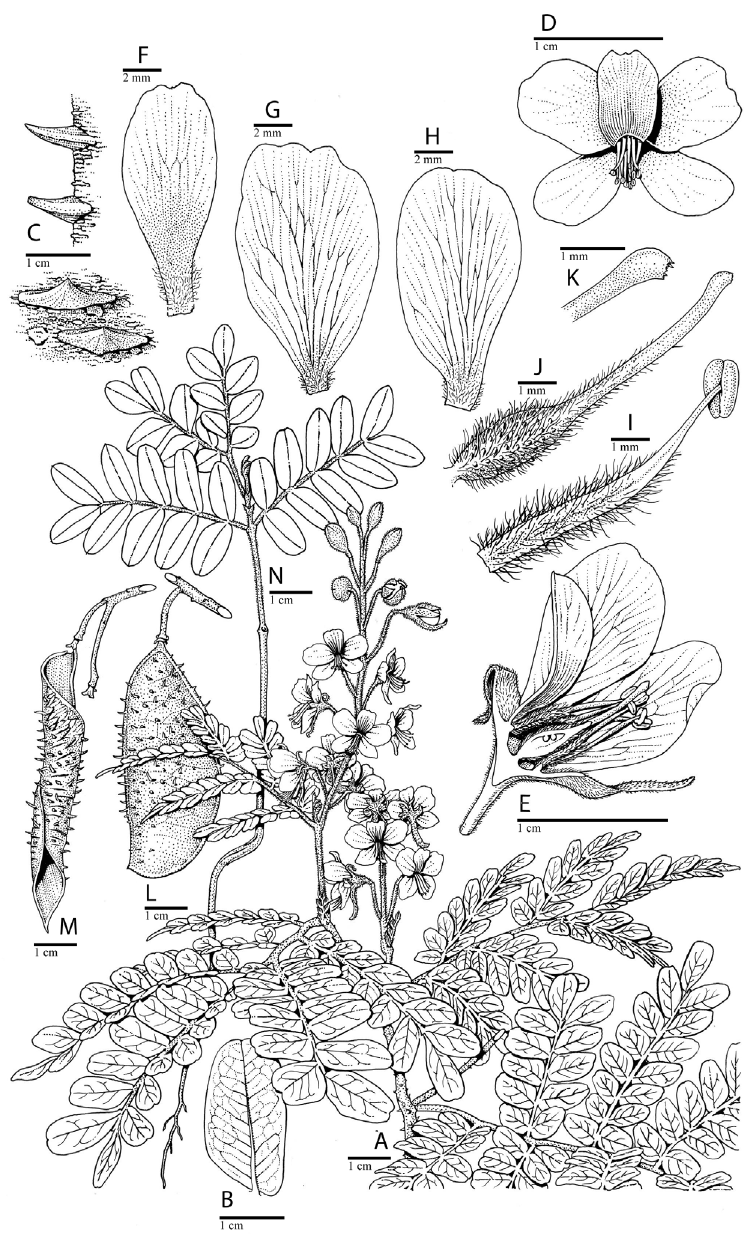
Figure 8. Paubrasilia echinata (Lam.) E. Gagnon, H. C. Lima & G. P. Lewis. A inflorescences and foliage B leaflet undersurface C bark armature (front and side views) D flower E flower l.s. F median petal G upper lateral petal H lower lateral petal I stamen J gynoecium K stigma L fruit M single valve of dehisced fruit N seedling. A from Glaziou 6839 B, K from Angeli 201 C, M from Lewis et al. 1634 D from Lima et al. 2705 E–J from Ducke 20623 L from Mell s.n., N from Lewis et al. 1624. Drawn by Tim